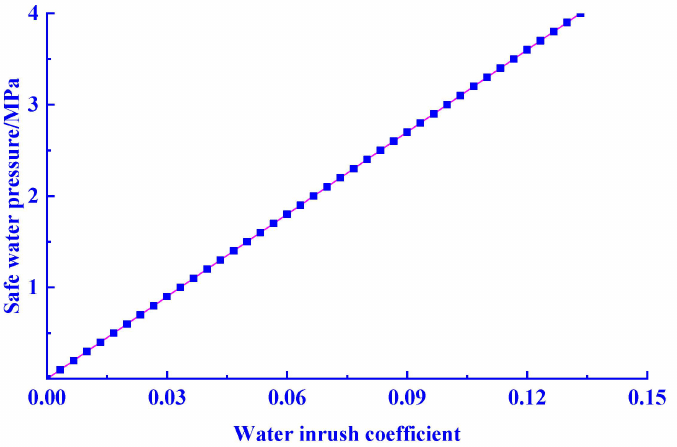
Figure 11. Relation between water inrush coefficient and safe water